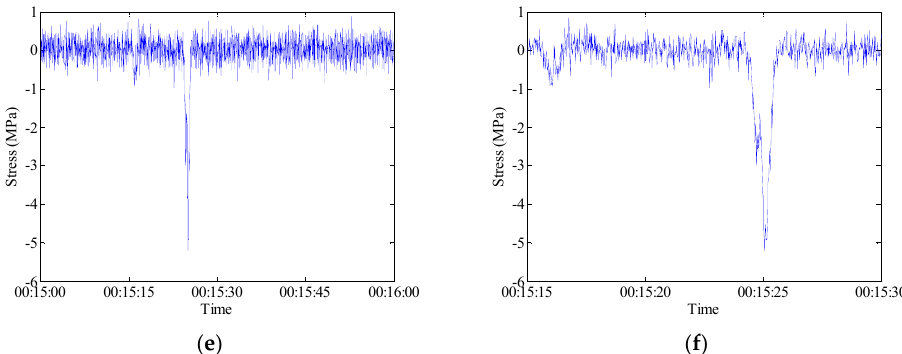
Figure 8. Raw data measured by FBG-MS-NS-2-3: ( a ) Stress time history; ( b ) Temperature time history; ( c ) Live-load induced stress time history; ( d ) Live-load induced stress time history in 1 h; ( e ) Live-load induced stress time history in 1 min; ( f ) Live-load induced stress time history in 15 s.